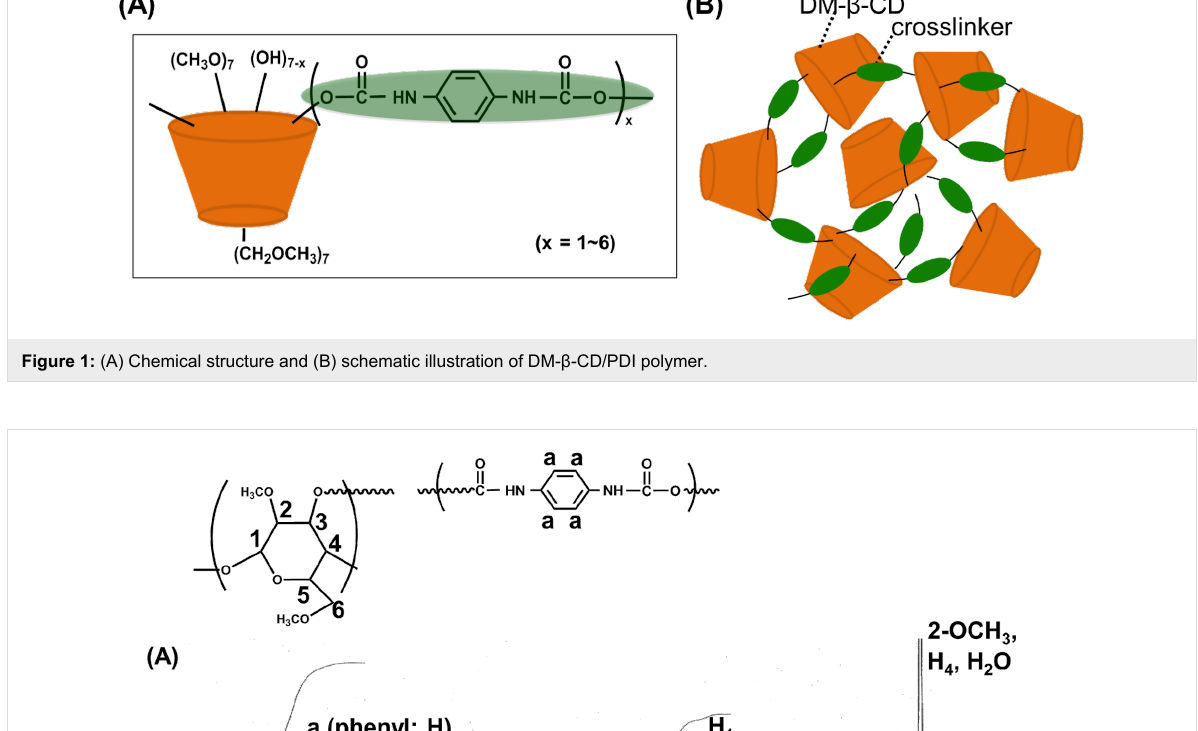
phenylene dicarbamyl (PDC) segments are broadened due to the restricted movement of the network linkage of the polymer. The integral ratio of the peaks for the phenyl groups in PDC to the peaks of H 1 protons of DM- β -CD indicates that the PDC/DM- β - CD ratio is two. The appearance of C=O stretching bands from urethane (1714 cm − 1 ) in the FTIR spectrum (Supporting